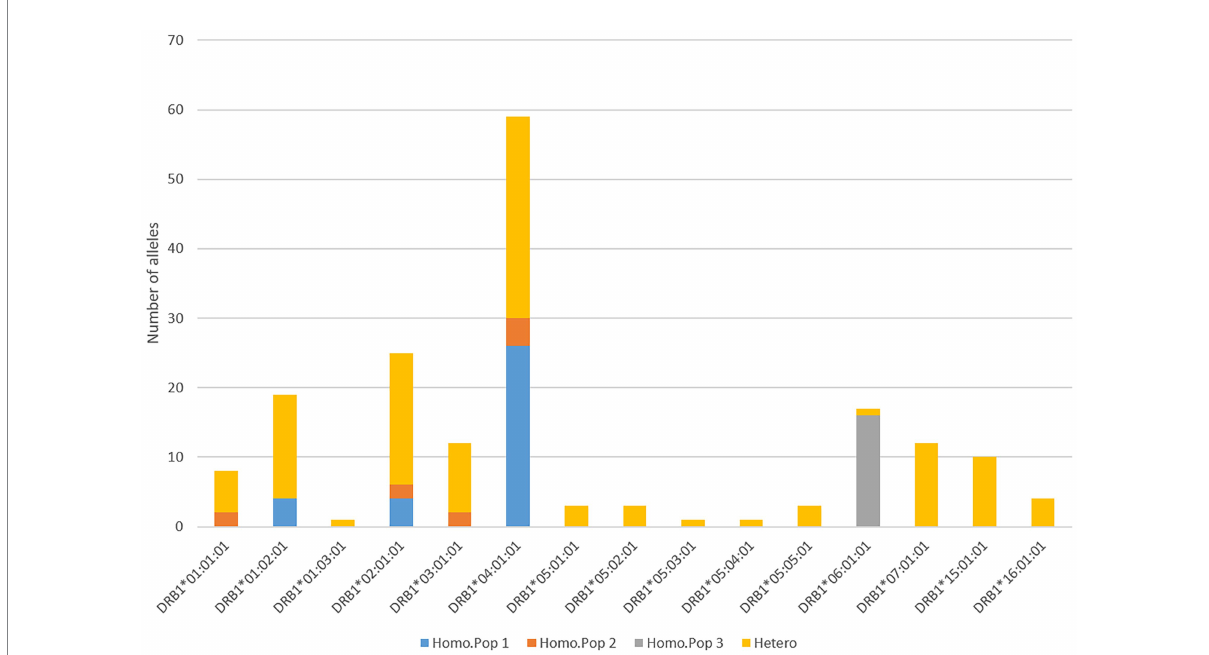
FIGURE 5 Homozygosity at DRB1 locus. Diagram shows the number homozygous DRB1 alleles per each of the three populations where blue defines homozygous alleles from population 1 (Homo.Pop 1), red from population 2 1 (Homo.Pop 2), and grey from population 3 1 (Homo.Pop 3), while remaining alleles in heterozygous (hetero) pairs are show using orange.